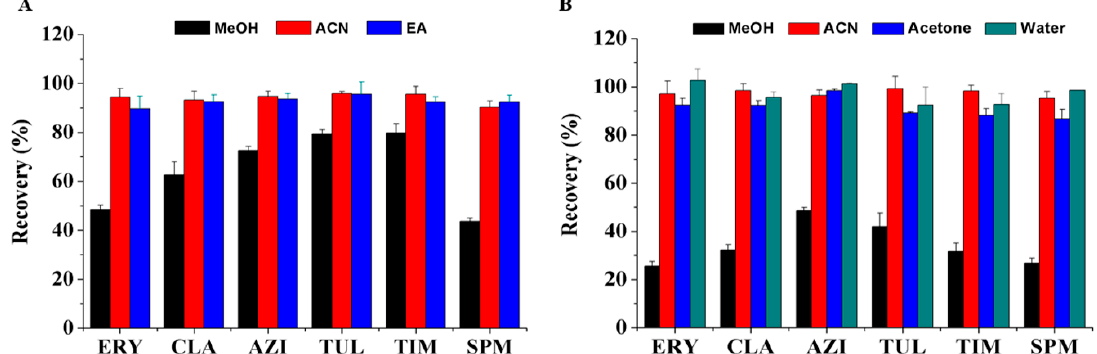
Figure 4. Effects of ( A ) methanol (MeOH), acetonitrile (ACN) and ethyl acetate (EA) as loading solvents and ( B ) MeOH, ACN, acetone and water as washing solvents on the recoveries of six macrolide drugs: erythromycin (ERY); clarithromycin (CLA); azithromycin (AZI); tulathromycin (TUL); tilmicosin (TIM); and, spiramycin